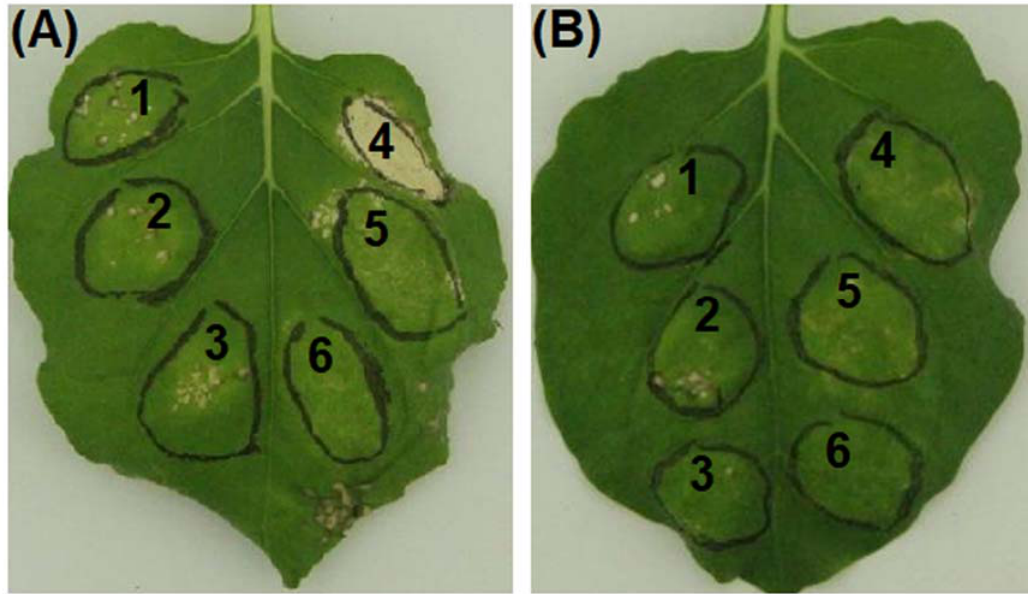
Figure 2. Suppression of BAX ‐ and elicitin protein INF1 ‐ mediated cell death of Nicotiana benthamiana